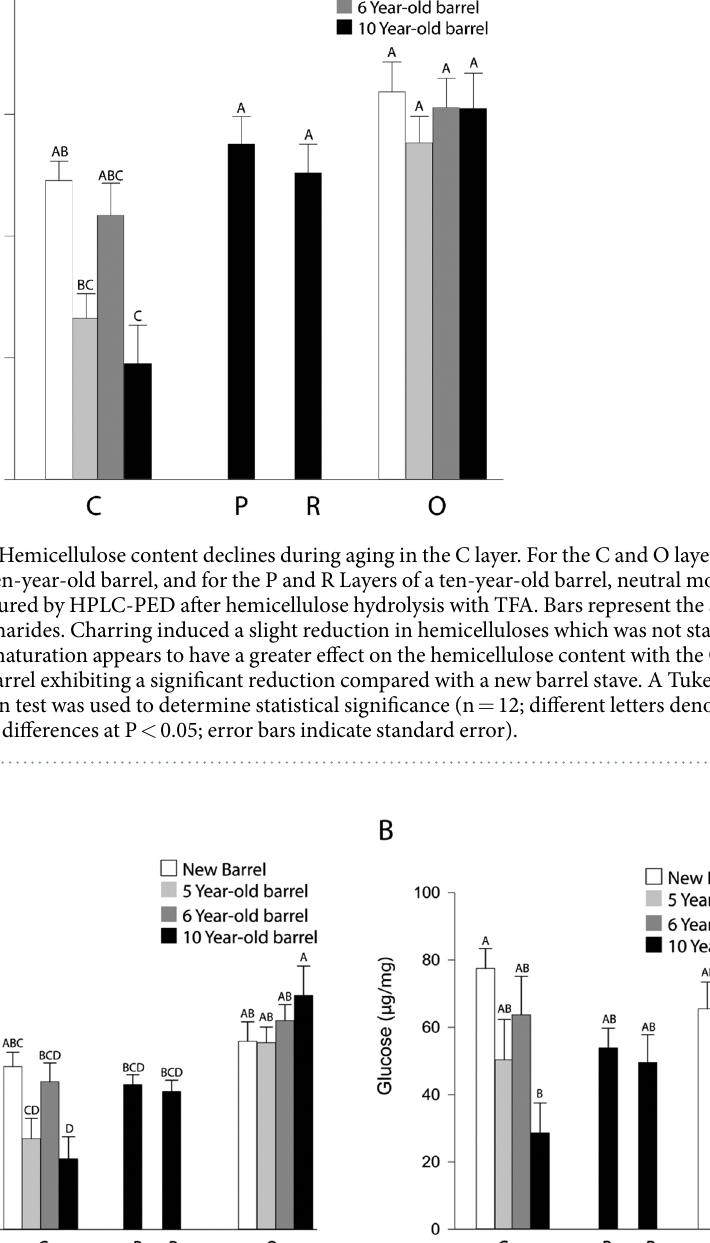
high performance liquid chromatography (HPLC) and detected by pulsed electrochemical detection (PED). The findings for cellulose mirrored those obtained by the Updegraff method, in that charring did not change cellu- lose content and that whiskey maturation degraded the content of cellulose found in the C layer of the barrel (Supplementary Fig. 3). Cellulose values in the O layers of the new and ten-year-old barrel were found to be 288 to 298 µ g/mg, similarly to the previous analysis (Supplementary Table 4 and Fig. 3). In contrast to the previous